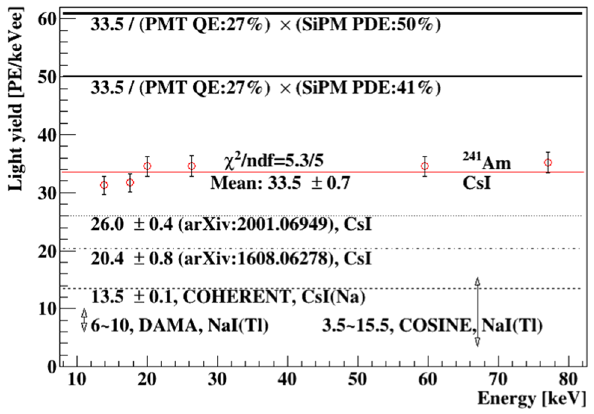
Table 2 Fitting results of 241 Am peaks in the energy spectrum. The 13.9, 17.5 and 21.0 keV ones are obtained from the fitting shown in Fig. 7. The 26.3 keV ones are obtained from the fitting shown in Fig. 8.